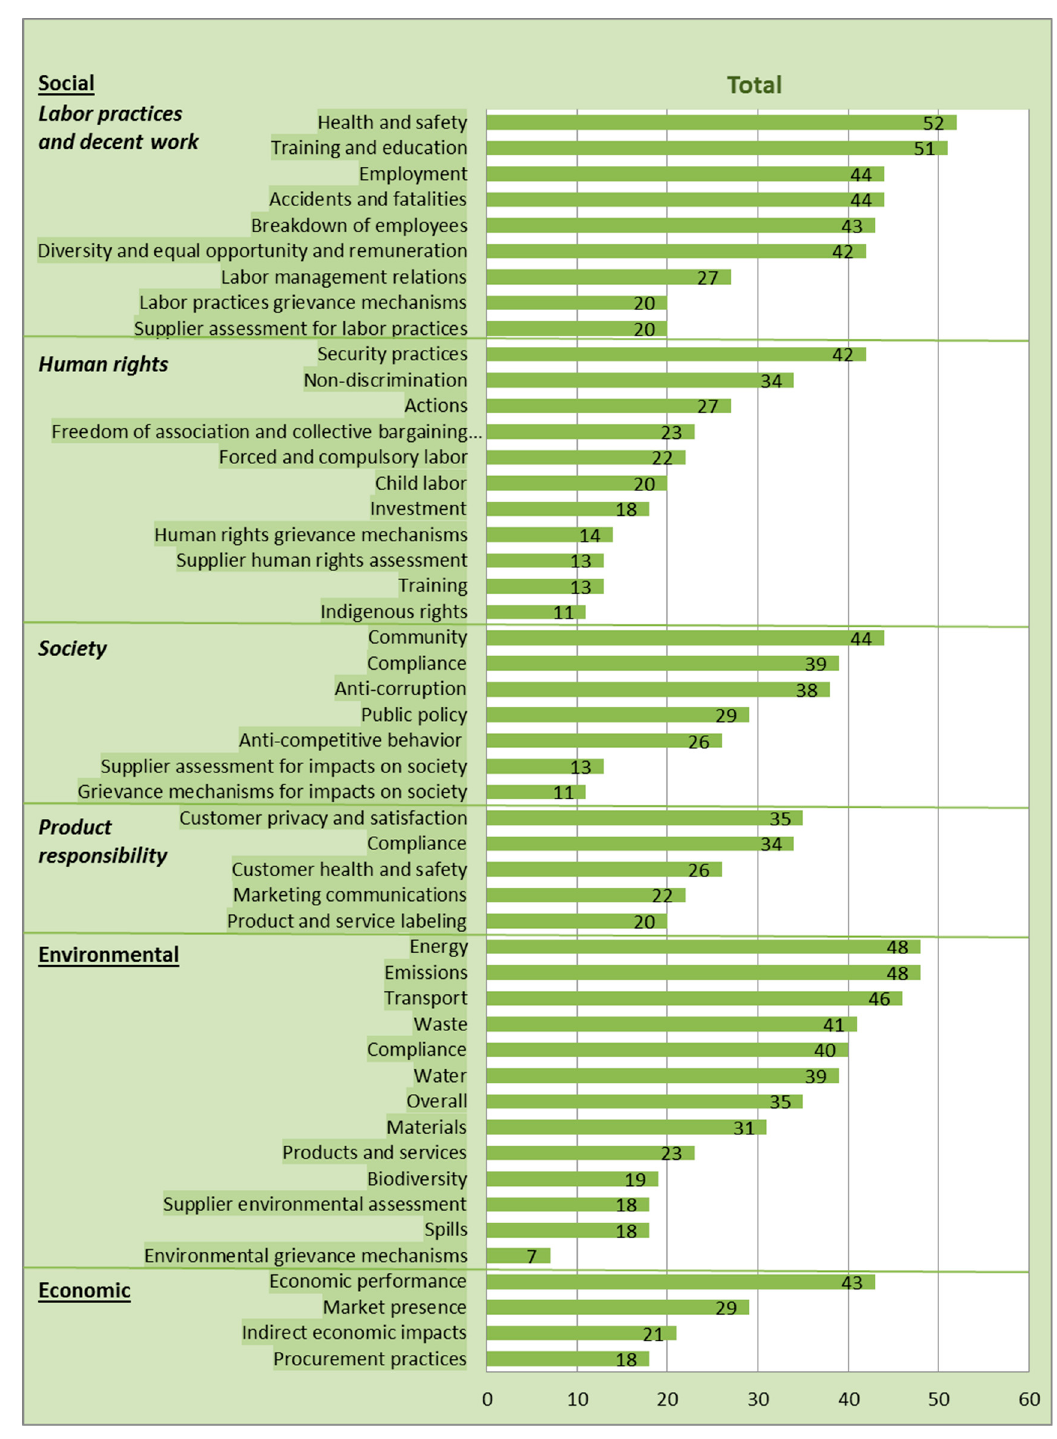
Figure 7. Overview of the results.